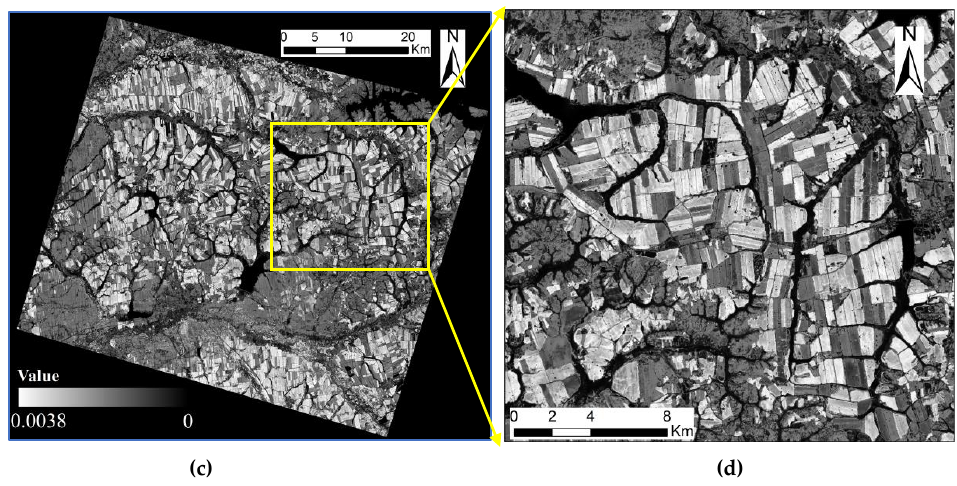
Figure 10. Composite enhanced feature images of soybean ( a , b ) and maize ( c , d ).